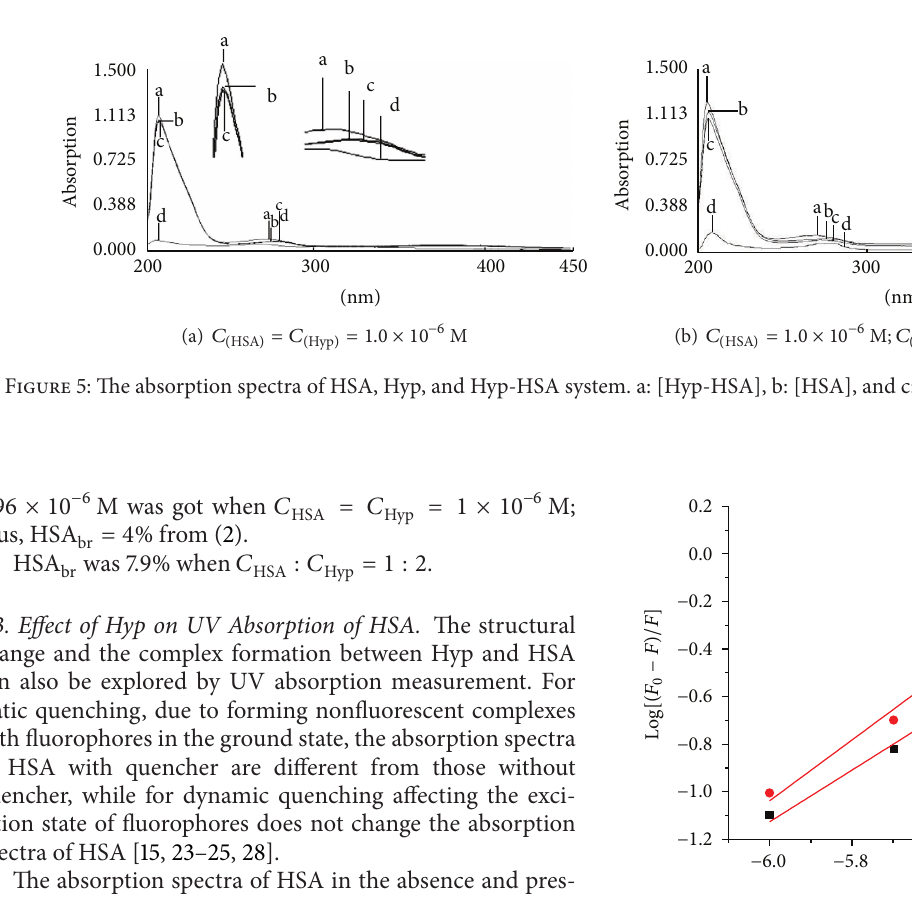
0.96 × 10 −6 M was got when 𝐶 = 4 % from (2). thus, HSA br